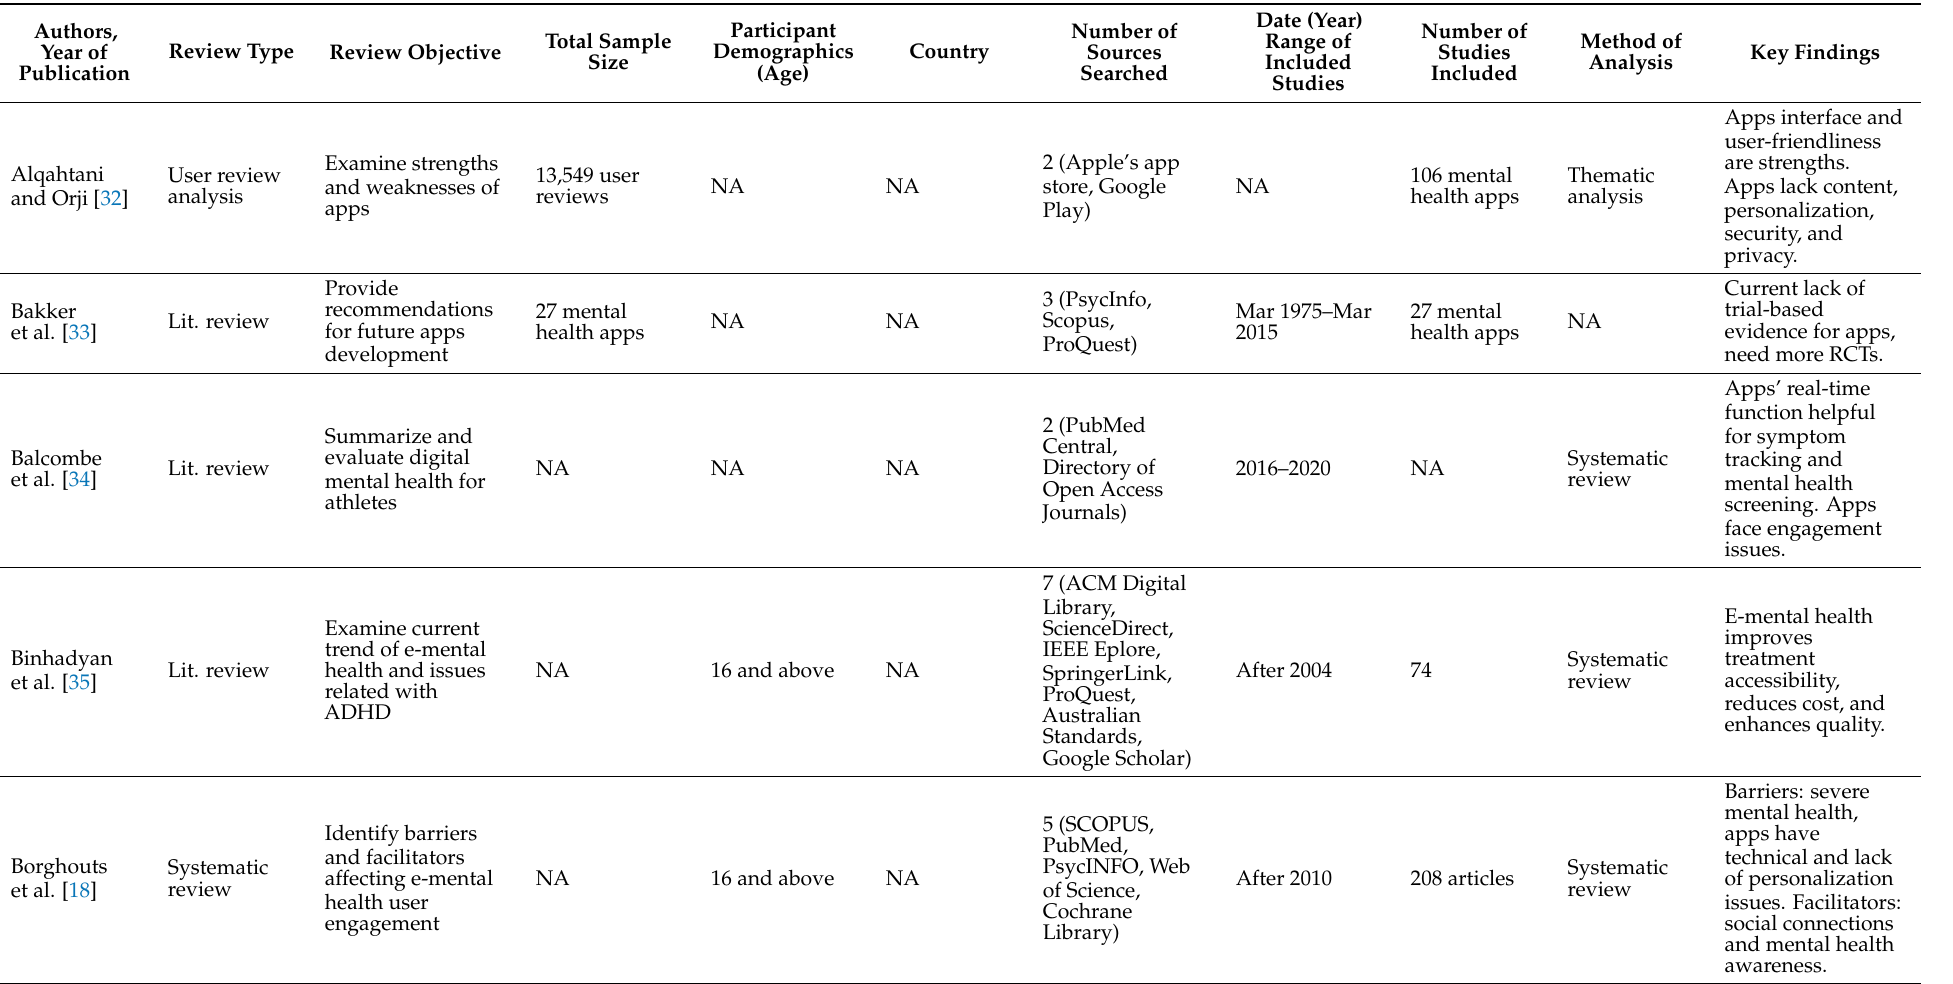
Table 2. Characteristics of included